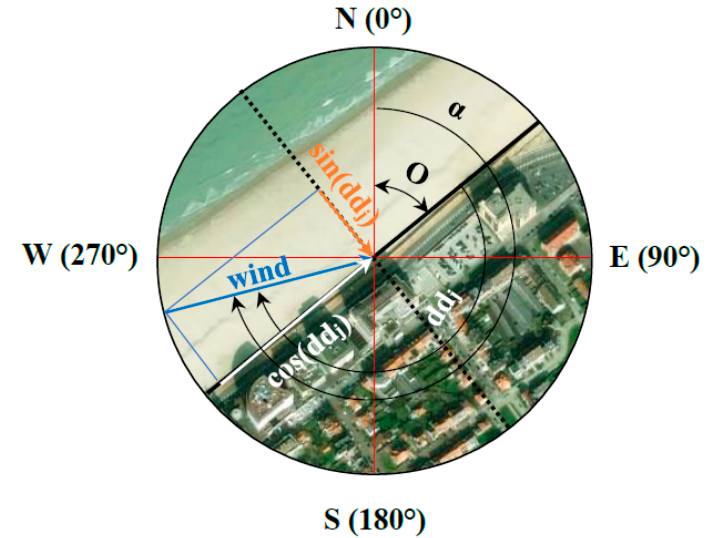
Figure 8. Orientation (O) of the Belgian coastline and calculation procedure of potential transport. The orange arrow shows the onshore direction of sediment transport towards the dunes and is used to explain dune behavior. The angle α is the wind direction (with respect to the north) and the angle dd j is the difference between the wind direction and coastal orientation O.